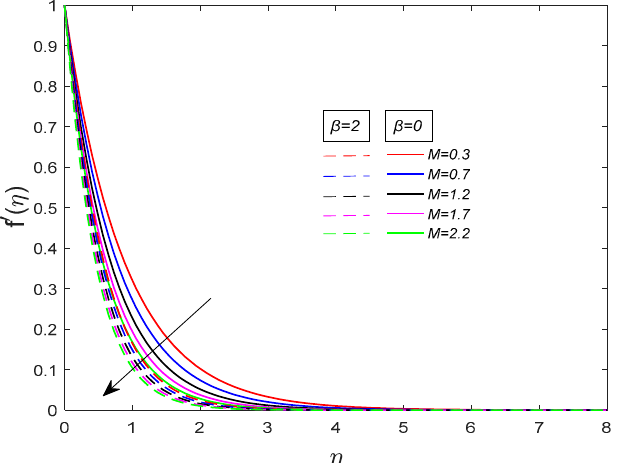
Figure 2. Effect of magnetic parameter (M) on normal velocity profile with Pr = Sc = 0.7, Ec = Kr = Sr = 0.1.